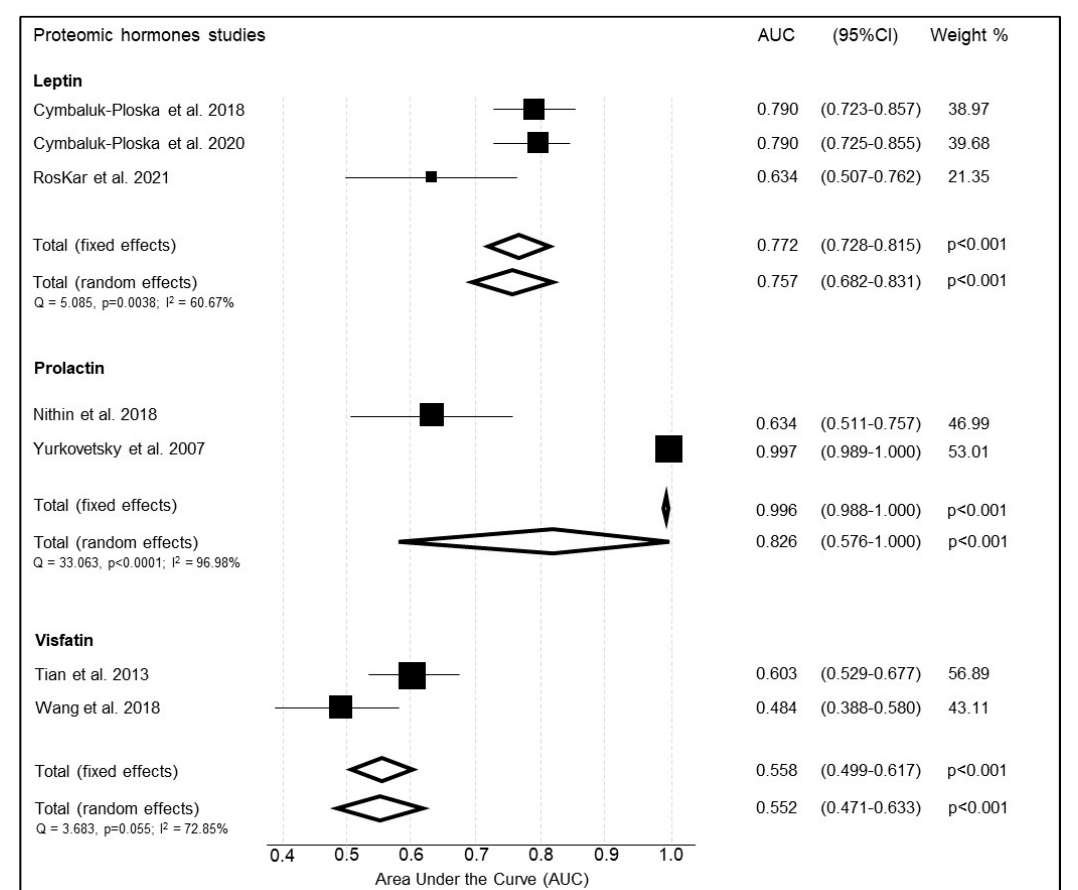
Table 12. Summary table of the performance of Visfatin.